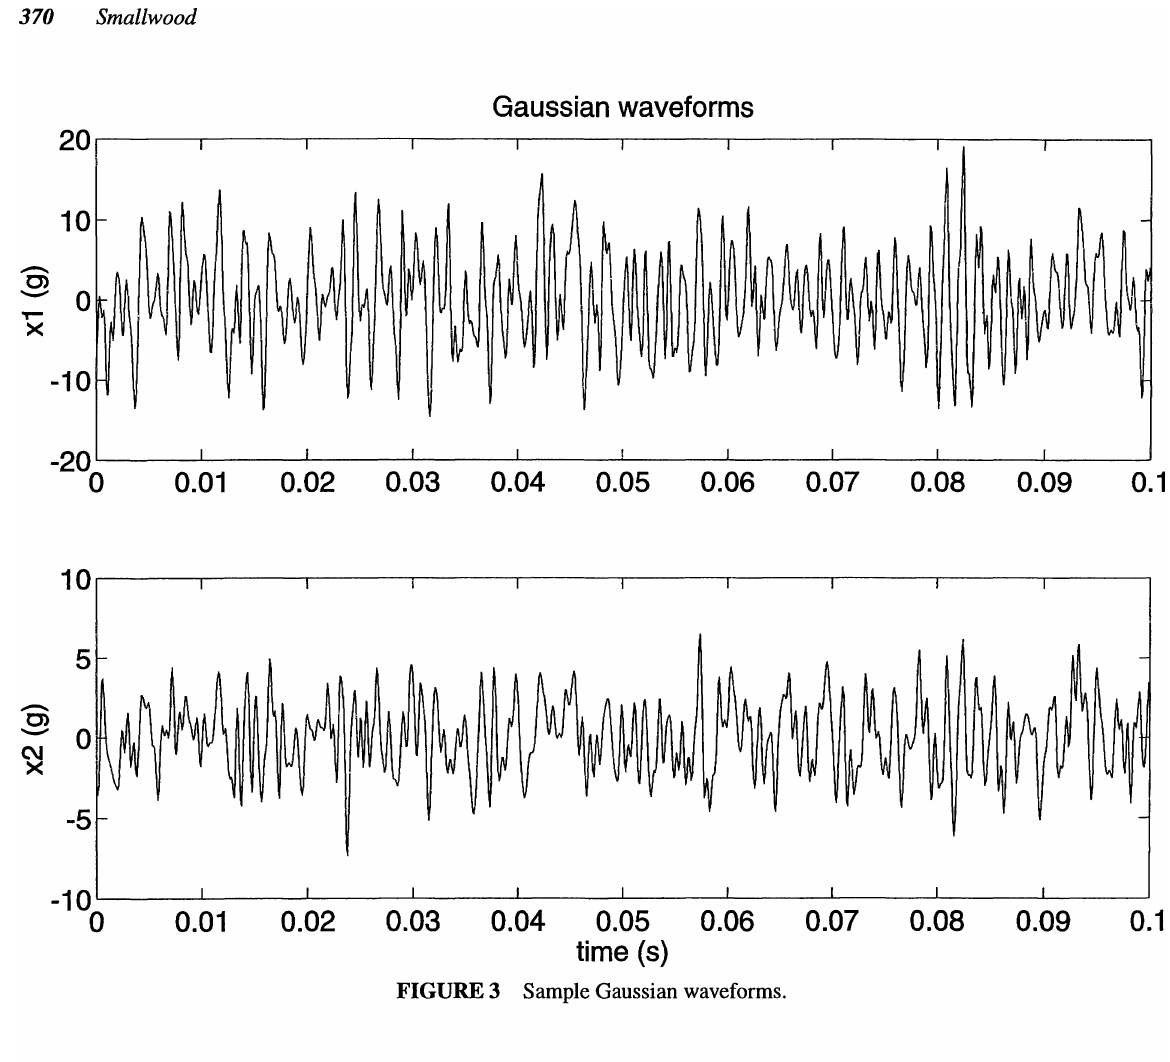
FIGURE 3 Sample Gaussian